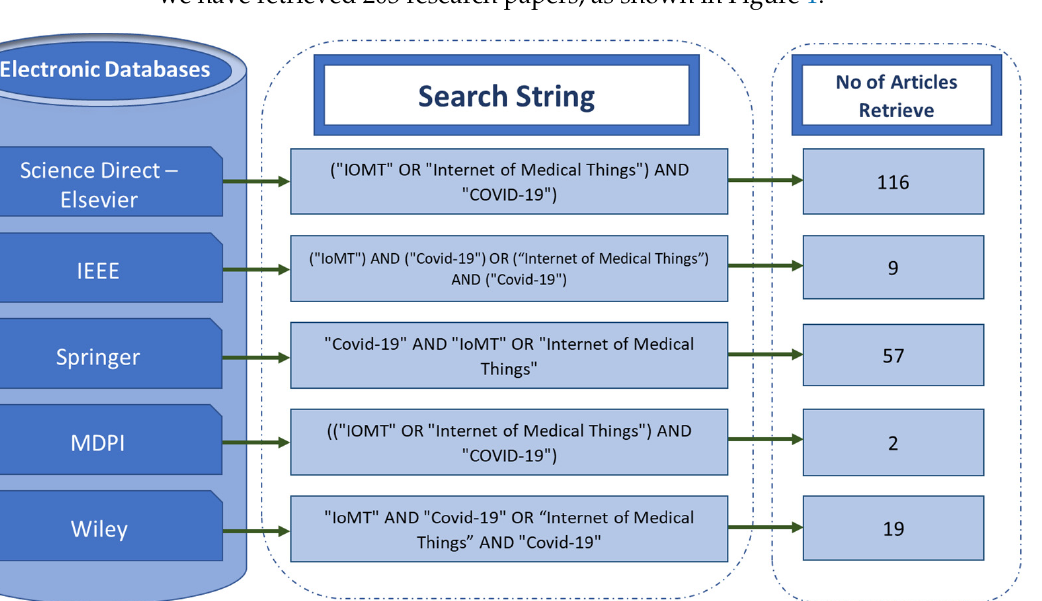
Table 1. Search string for different publication databases. Electronic Database